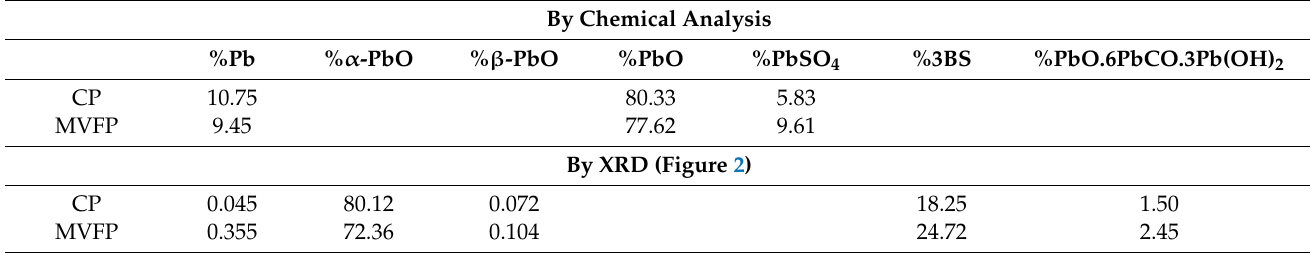
Table 5. Comparison of the chemical analysis by titration and XRD of the negative pastes before curing. By Chemical Analysis